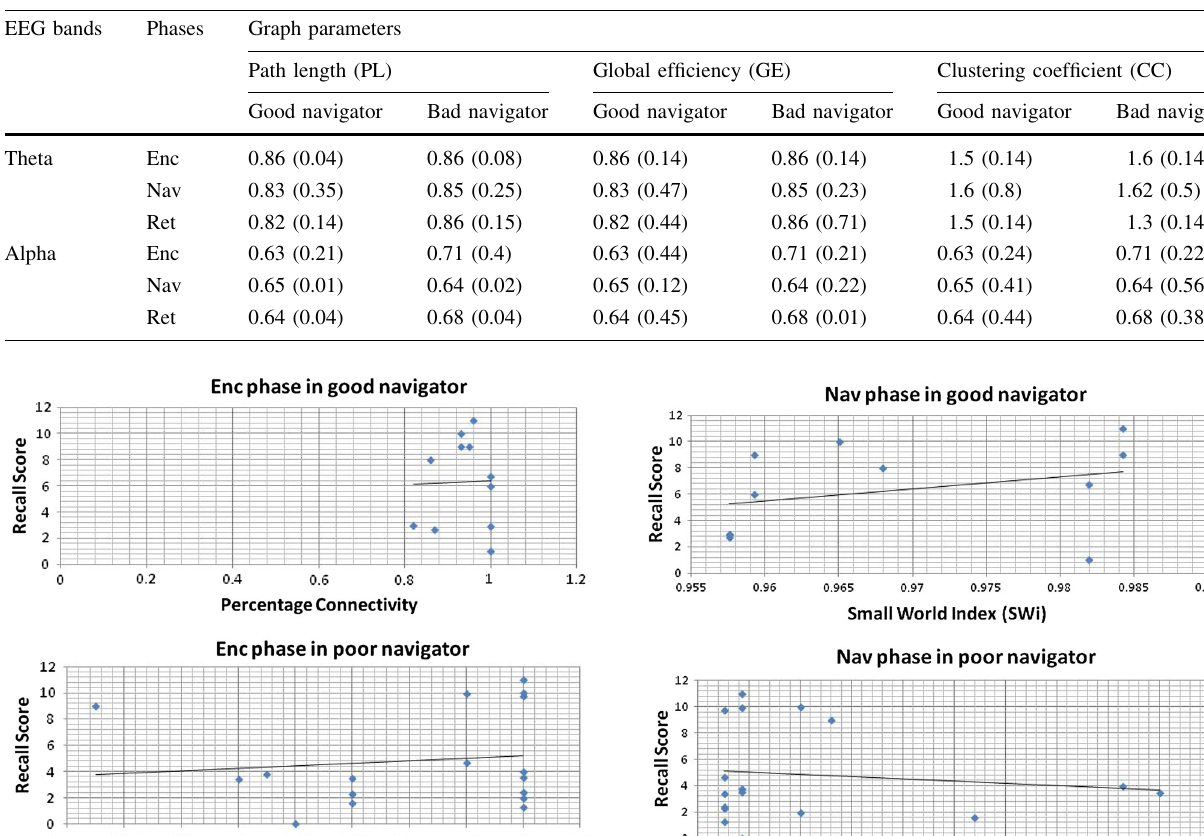
Table 1 Mean (SD) for the graph parameters in different phases for theta and alpha bands